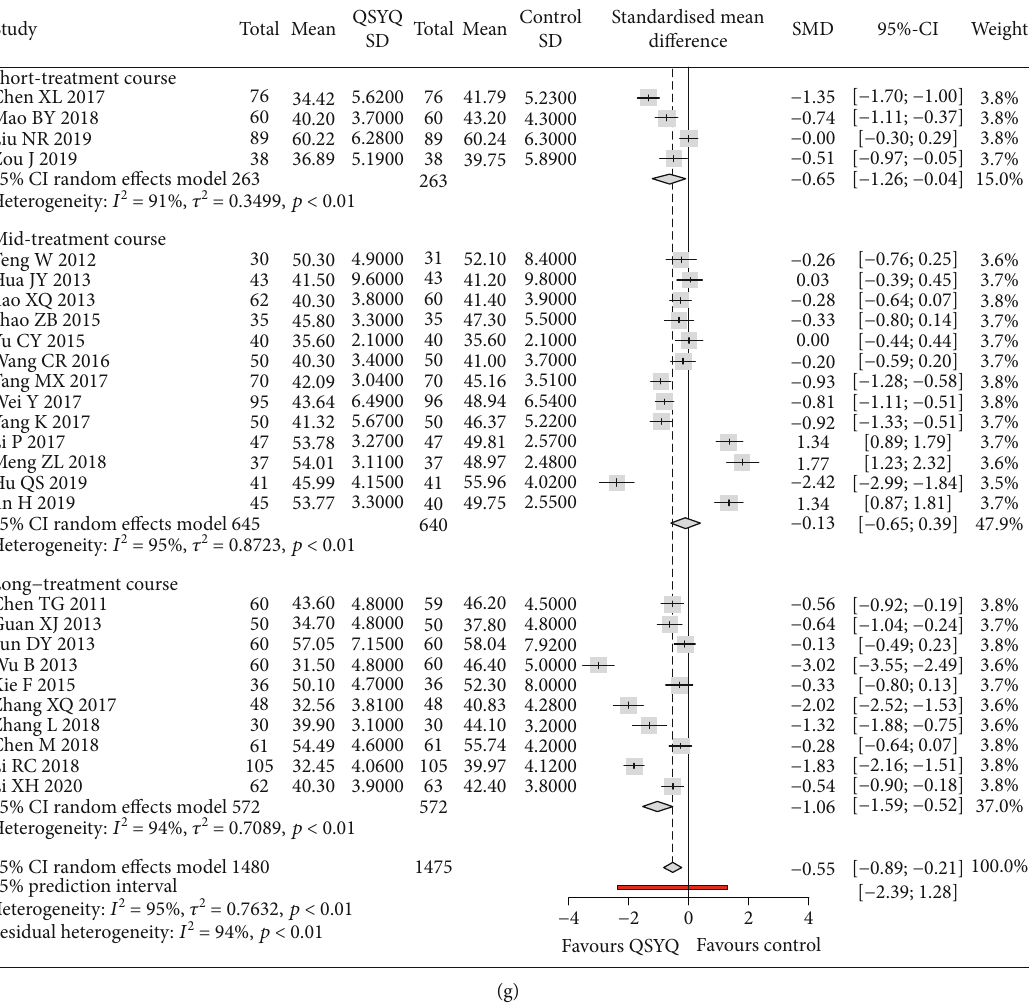
Figure 2: Forest plot of the meta-analysis of QSYQ addition on outcome parameters: (a) the forest plot for 6MWD; (b) for BNP; (c) for NT- pro BNP; (d) for cardiac index; (e) for LVEF; (f) for LVEDD; (g) for